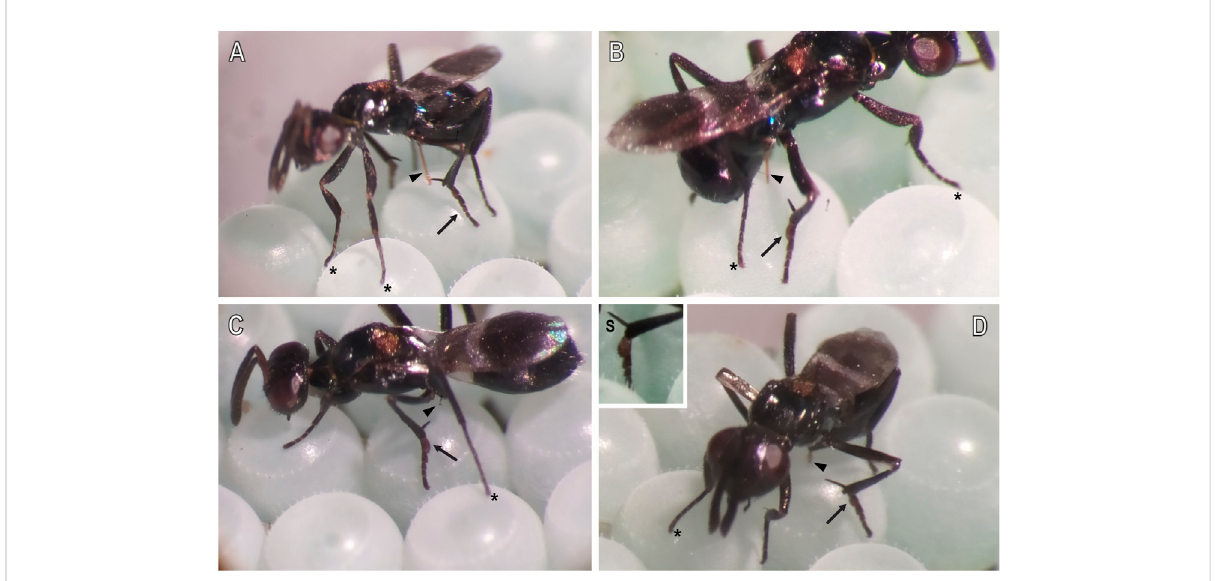
FIGURE 6 Interactionbetweenthetarsiofegg-layingfemalesof A.bifasciatus andtheeggsurfaceof H.halys observedwiththestereomicroscope. (A – C) , Different steps during oviposition up to the insertion of the ovipositor (arrowhead) into the egg [ (D) and inset]. Note that forelegs and hindlegs (marked with asterisk) are in contact with the egg chorion only through the tarsal tip and the pretarsal attachment devices (claws and arolium), while in the midlegs the ventral surface of the whole tarsus (arrow) is in close contact with the chorion. In the midlegs, the tibial spur (S) is contacting the egg surface and forms a wide angle with the